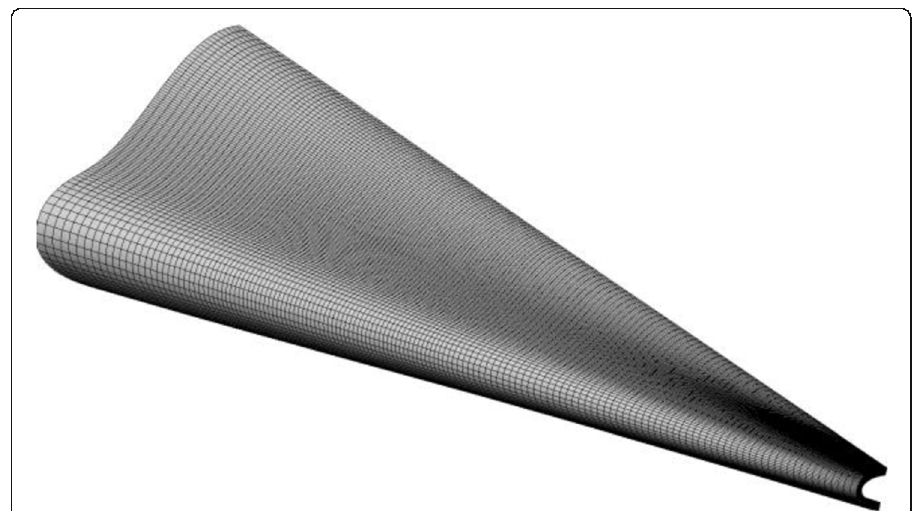
Fig. 4 Computational domain and grid of direct numerical